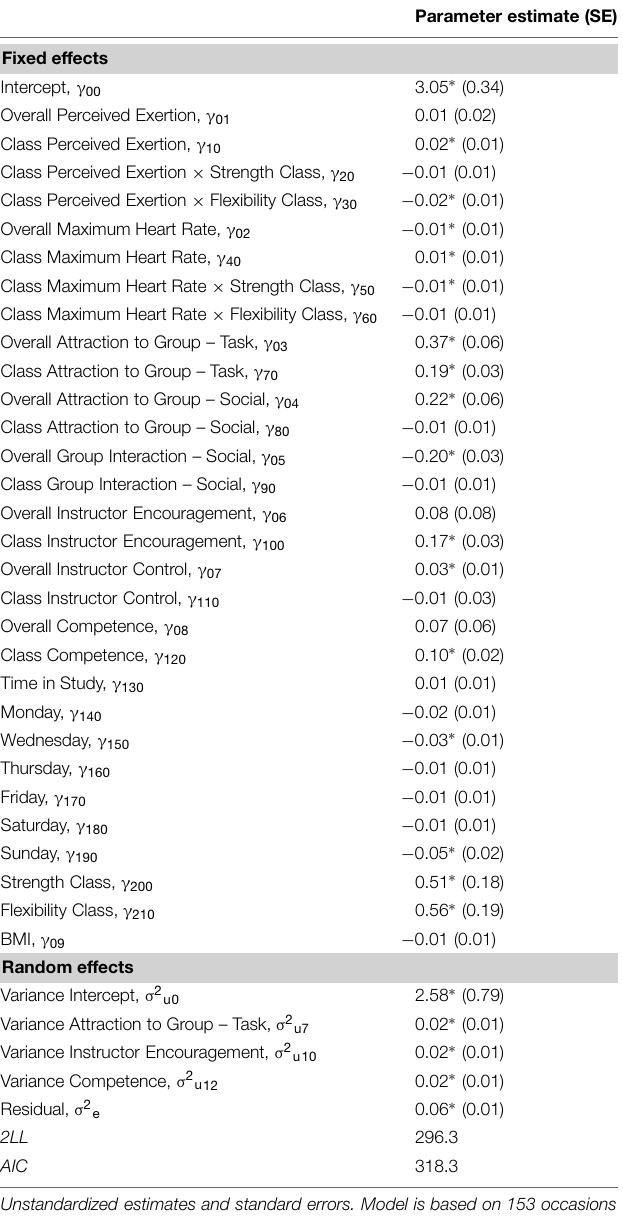
TABLE 2 | Results from multilevel model examining between-person and within-person associations of predictor variables with intrinsic